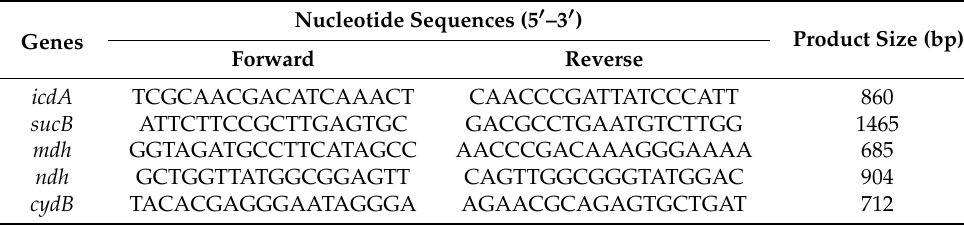
Table 1. Primers in PCR for B. subtilis WB800.